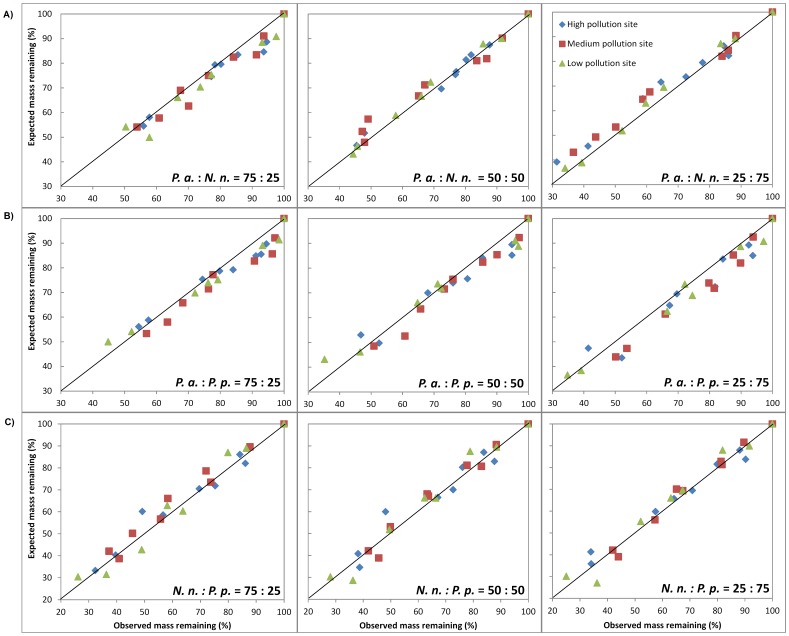
Dry mass remaining in the species mixtures.Mean percentages of observed dry mass remaining (O.) and expected dry mass remaining (E.) in the species mixtures of A) P. a. and N, n. B) P. a. and P. p. and C) N. n. and P. p. over the experimental period at Low, Medium and High pollution sites in Lake Baiyangdian. Deviation from 1∶1 line (solid line) suggests interactions in species mixtures on decomposition (Species abbreviations are, P. a.: Phragmites australis; N. n.: Nelumbo nucifera; P. p.: Potamogeton pectinatus L.).